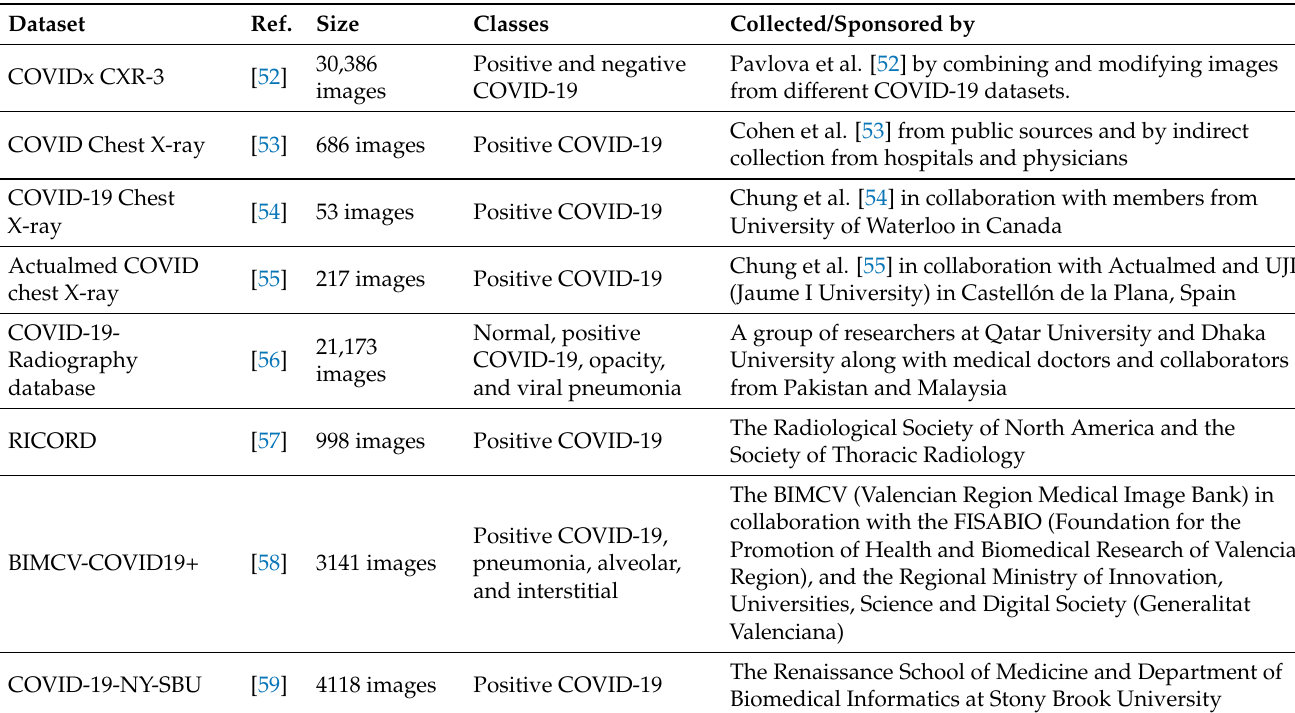
Table 2. Overview of publicly available COVID-19 CXR